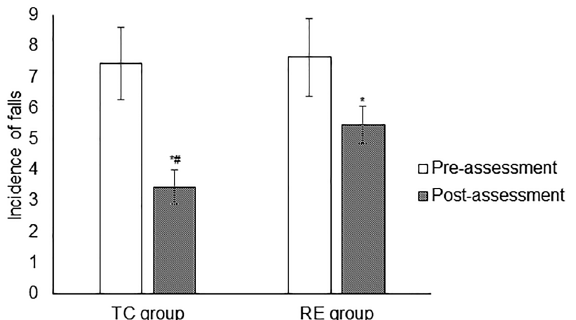
Figure 2. Incidence of falls for Parkinson ’ s disease patients who performed Tai Chi (TC) or routine exercise (RE) programs. Data are reported as means ± SD. Total number of patients enrolled were 250 for both groups. *P o 0.05 compared to pre-assessment; # P o 0.05 compared to RE group. Paired sample t -test was performed for statistical analysis. Pre-assessment: Incidence of falls in previous 6-months. Post-assessment: Incidence of falls within 6-months from start of physical therapy and follow-up